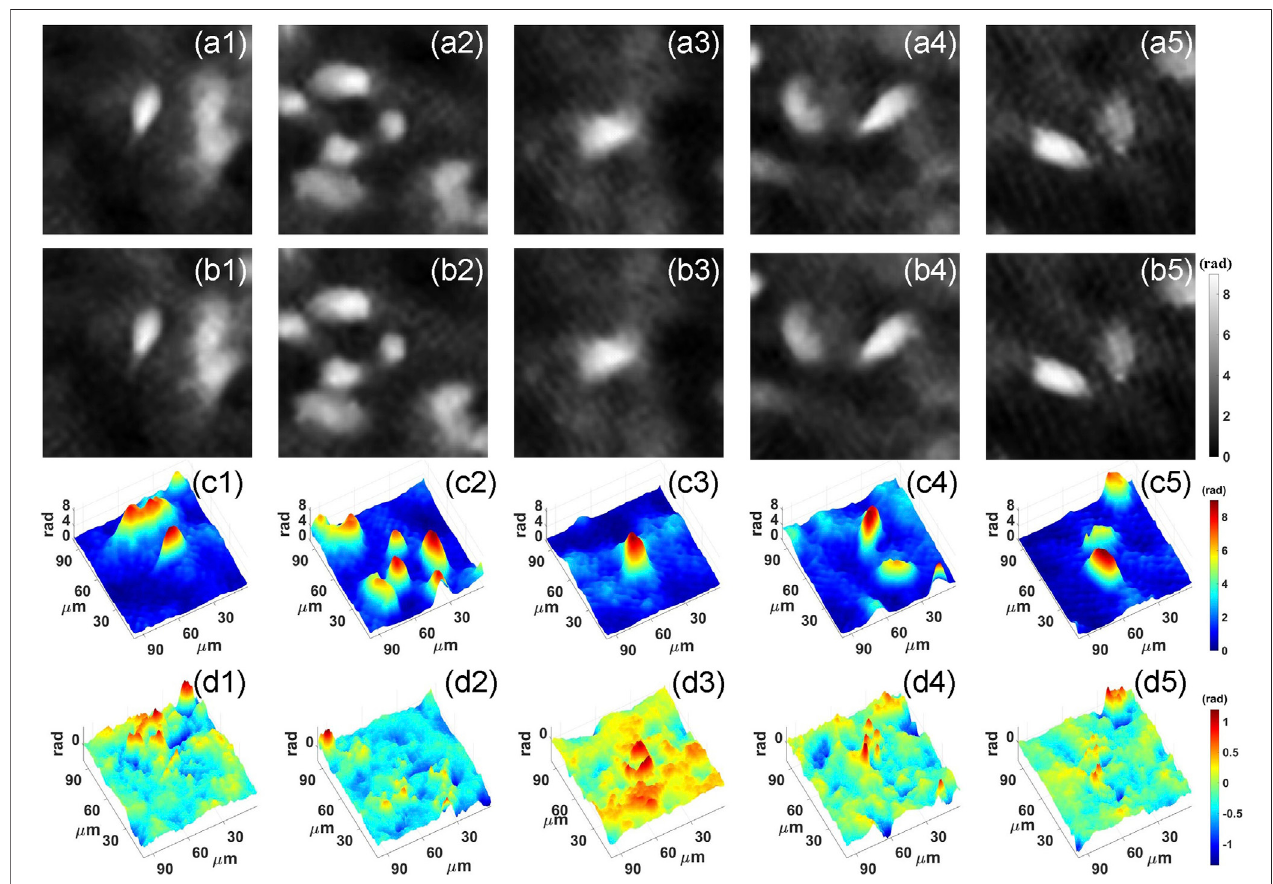
FIGURE4| Neuralnetworkreconstruction results. (A) Groundtruth; (B) PhaseNetreconstructionresult; (C) Three-dimensionalimage ofPhaseNetreconstruction result; (D) Three-dimensional image of error maps between Ground truth and PhaseNet reconstruction result.